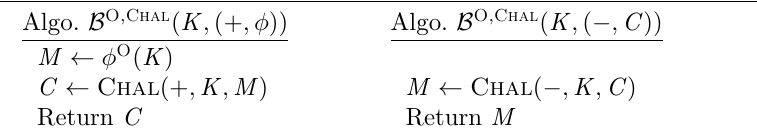
Figure 7: Algorithm B used for KDM analysis of the ideal